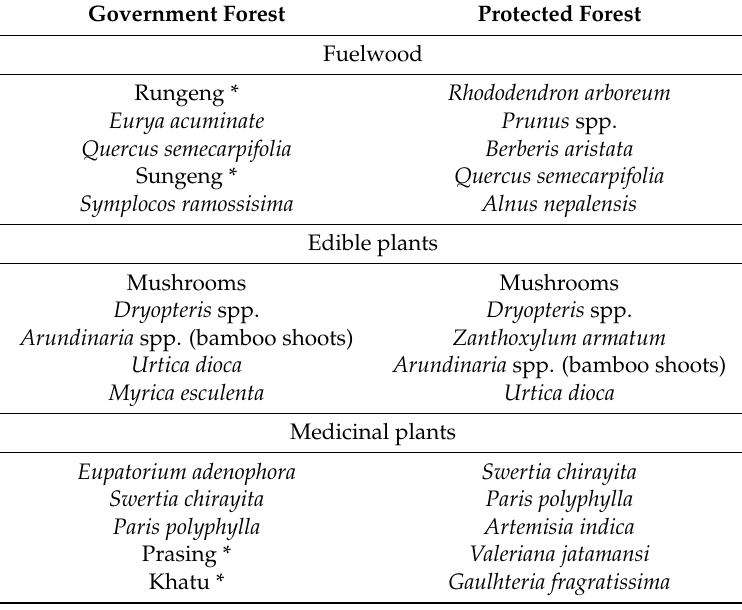
Table 6. Oversight over commonly used forest species found in protected forests inside Langtang National Park and in government managed forests outside, based on household interviews conducted at the two sites ( n = 44). Only the five most frequently mentioned species in each category are